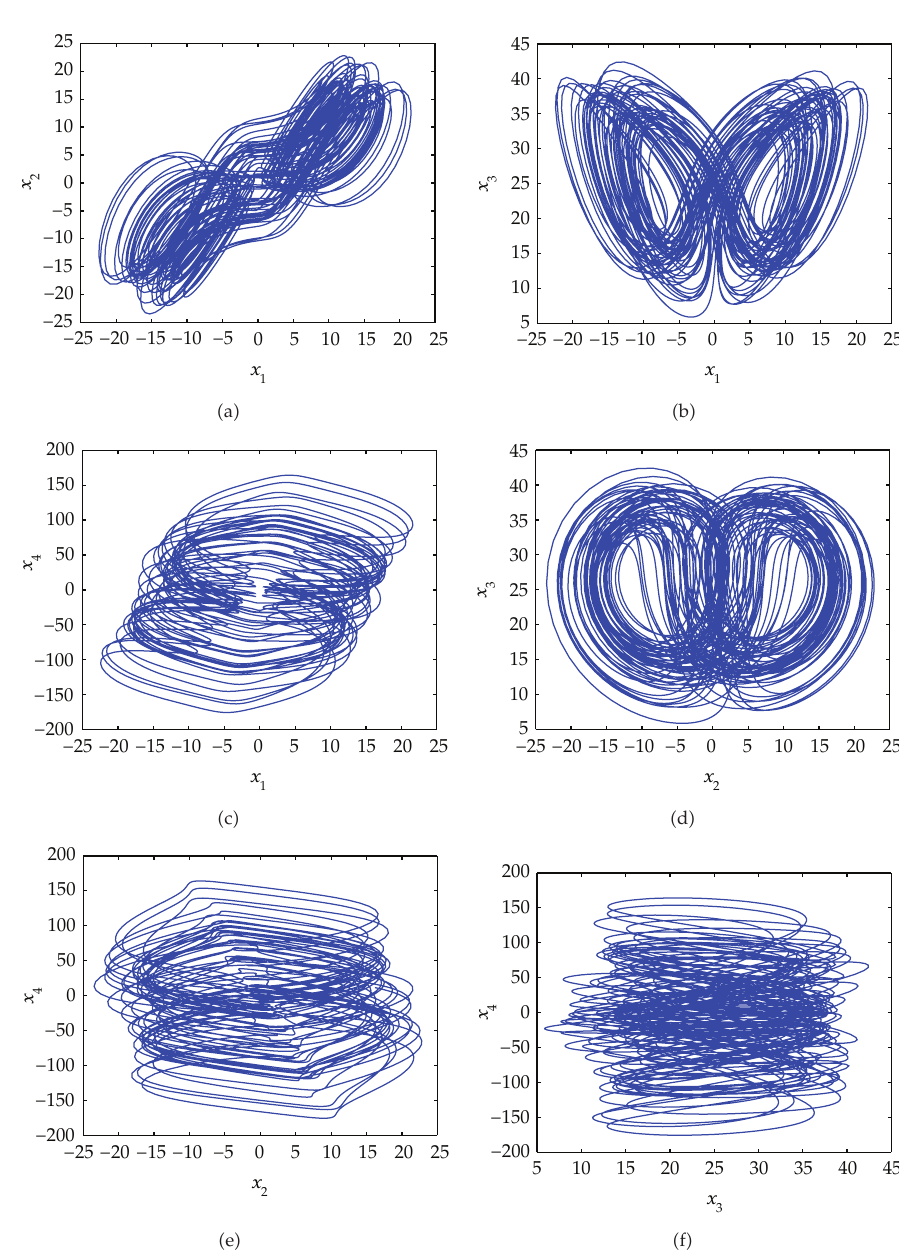
Figure 2: The projections of attractors of fractional-order hyperchaotic Lorenz system with order q (cid:8) 0 .